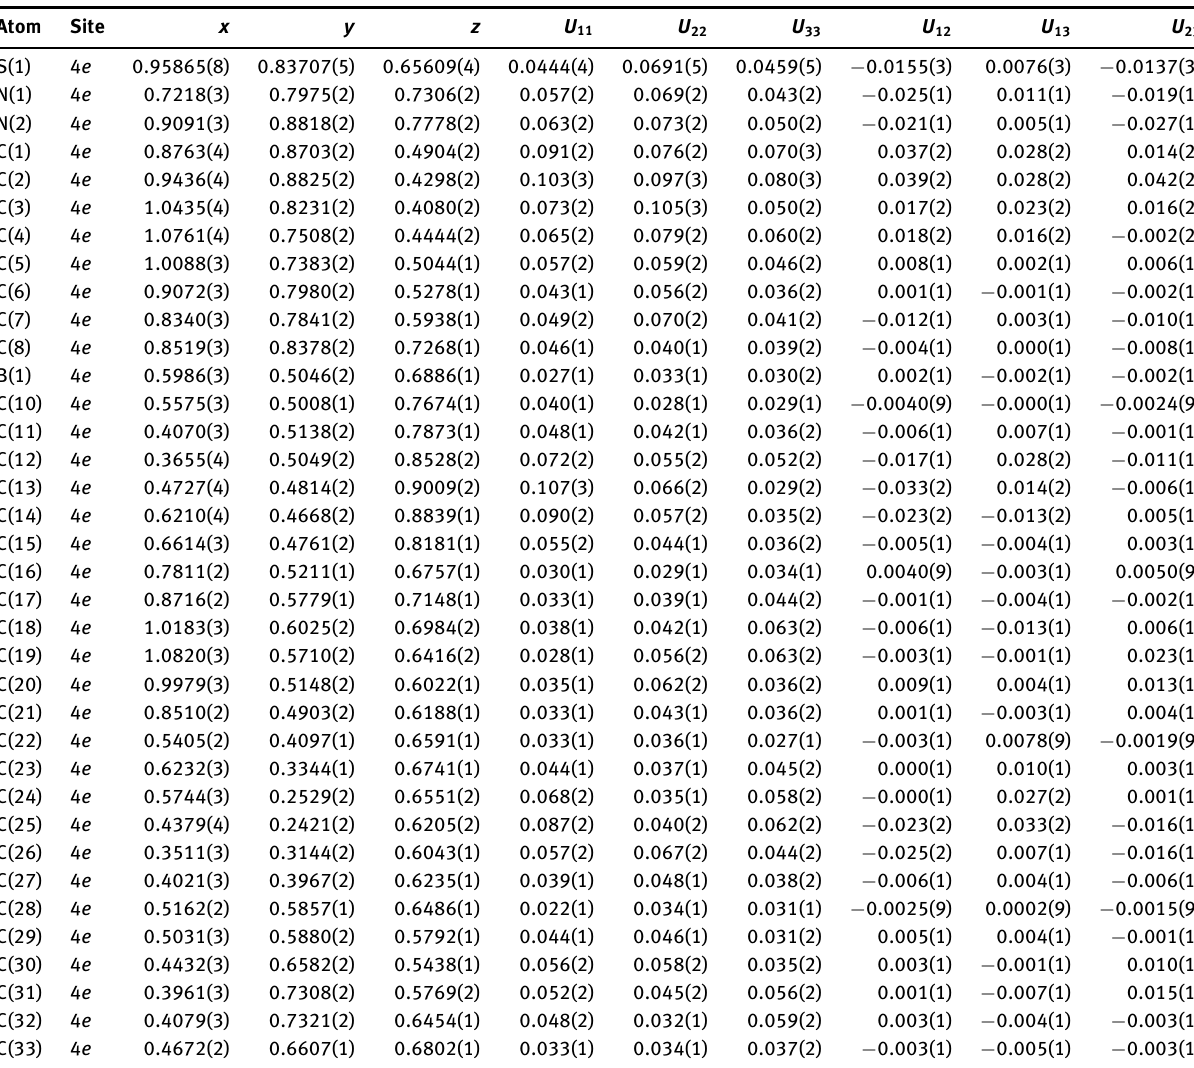
Table 3: Fractional atomic coordinate and displacement parameters (Å 2